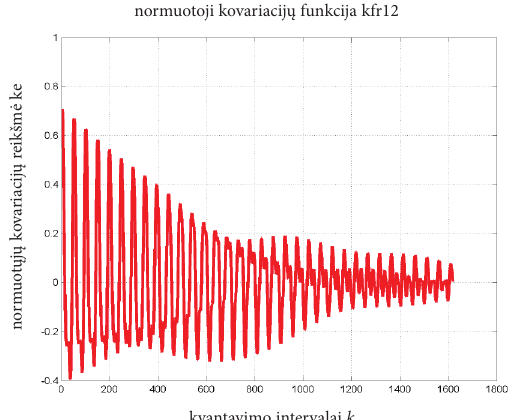
12 pav . Patologinių moteriškųjų ląstelių 21-osios 9 pav . Patologinių moteriškųjų ląstelių pirmosios 21-osios chromosomos skaitmeninio vaizdo tenzoriaus chromosomos ir trečiosios (priedinės) 21-osios chromosomos vektorinės kovariacijos koeficiento kaita tarpusavio normuotoji kovariacijų funkcija Fig. 12 . Change of the vector covariance coefficient of digital Fig. 9 . Interrelation normalised covariance function image tenzor of the abnormal female chromosome 21 in cells of the abnormal female first and extra (third) chromosome 21 in cells